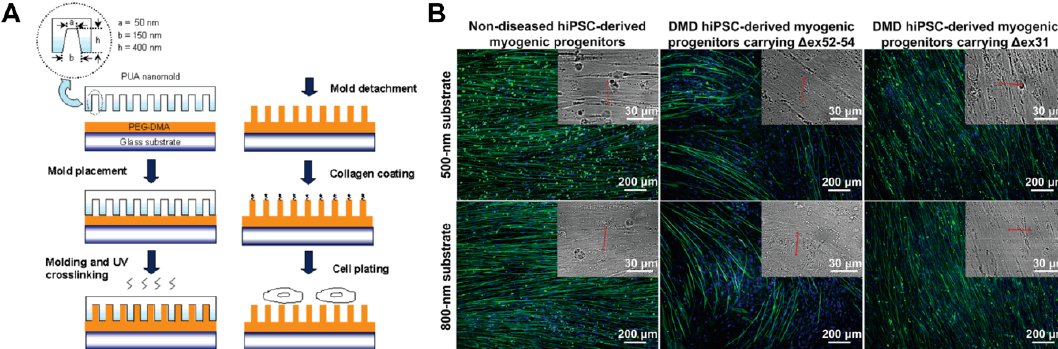
Figure 12. ( A ) Schematic illustration of poly(urethane acrylate) (PUA) nanopillar array mold fabrication by ultraviolet (UV)-assisted capillary lithography. ( B ) Difference in myotube alignment by nanogrooved substrates of the myogenic progenitors derived from Duchenne muscular dystrophy (DMD) hiPSC and normal hiPSC. Reprinted from [84,88]. Copyright (2006) American Chemical Society and (2018)